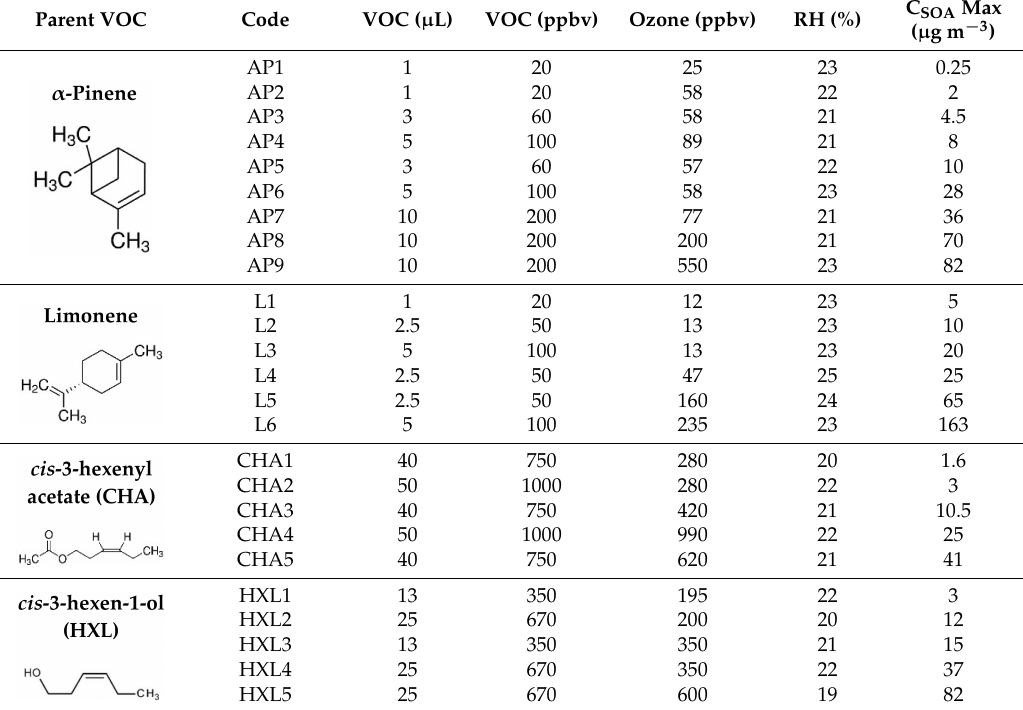
Table 1. Summary of experimental conditions. VOC: volatile organic compounds; RH: relative humidity. Parent